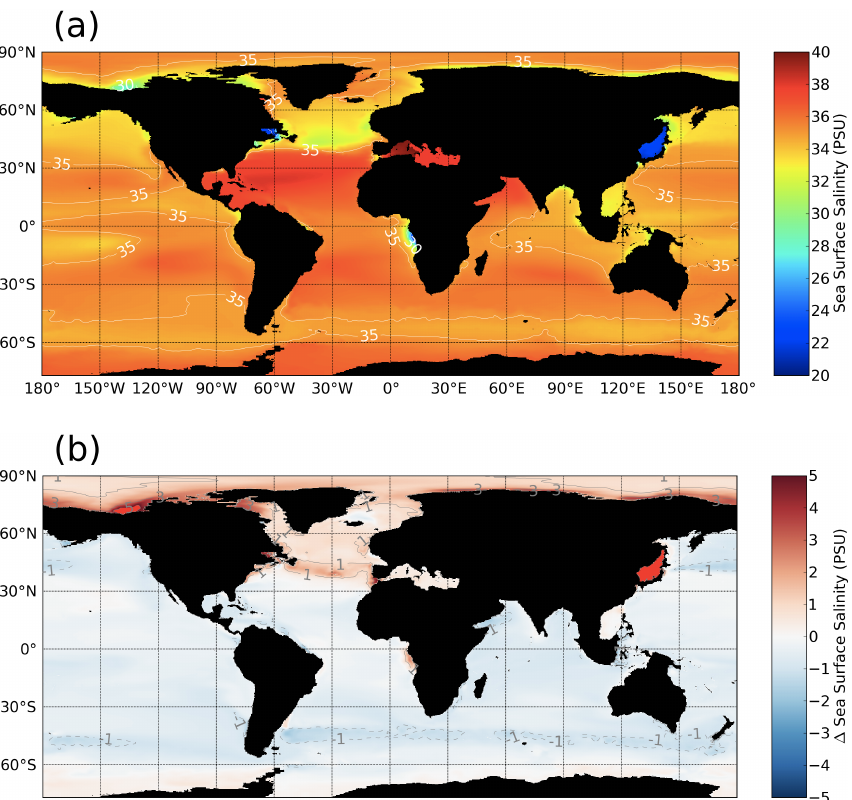
Fig. 2. Map of (a) the annually averaged Sea Surface Salinity (SSS) in the LGM eddy-permitting simulation and (b) the difference between the coarse resolution and the eddy-permitting simulation. Units in PSU.